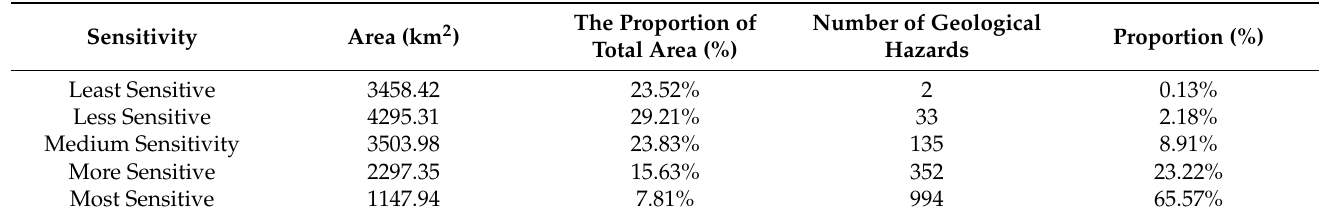
Table 5. Sensitive classification of geological disasters and proportion of disaster sites in Nujiang Prefecture.